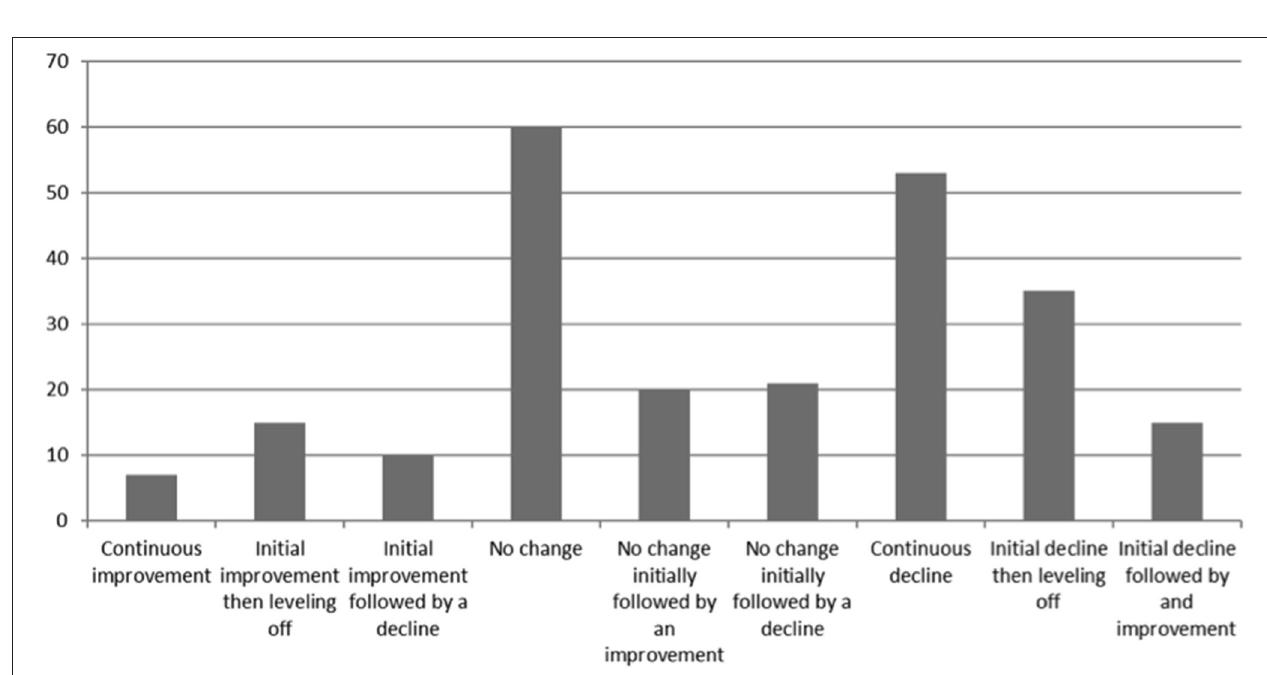
FIGURE 2 | Trajectory of change in mental